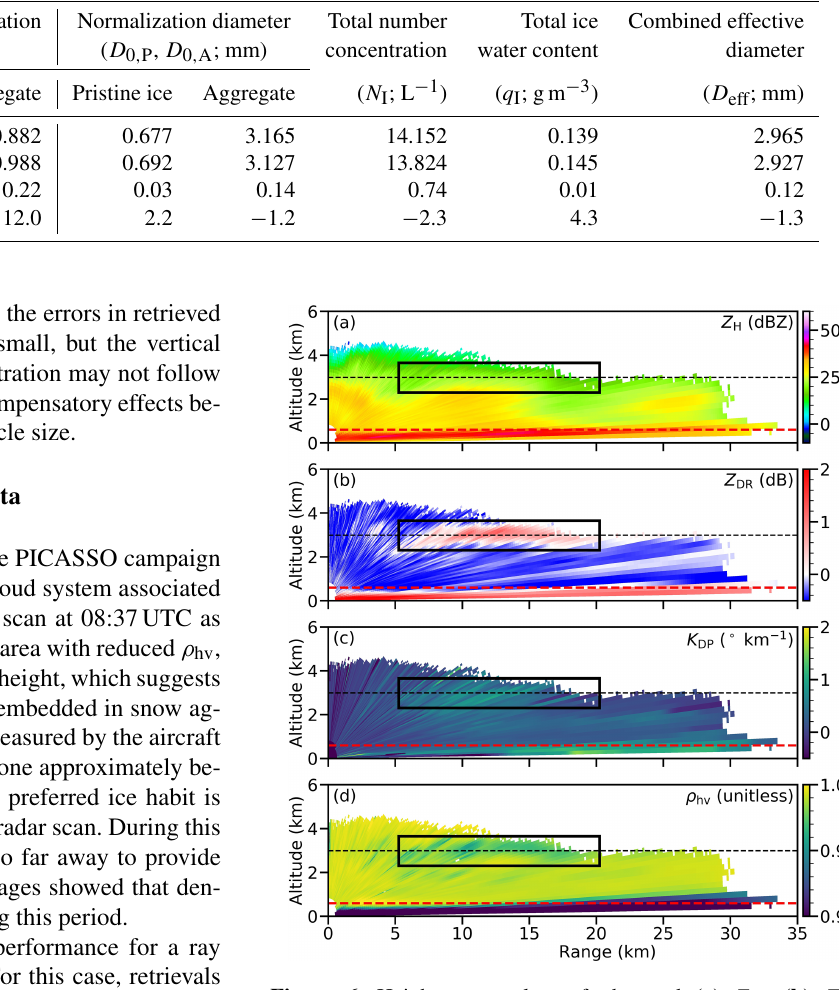
Figure 6. Height–range plots of observed (a) Z H , (b) Z DR , (c) K DP , and (d) ρ hv from the RHI scan at 08:37UTC on 13 Febru- ary 2018 during the PICASSO field campaign. The dashed red line denotes the 0 ◦ C level, while the dashed black line denotes the ap- proximate flight altitude of the FAAM aircraft during the scan. The black polygon denotes the region that has enhanced Z DR and K DP and reduced ρ hv